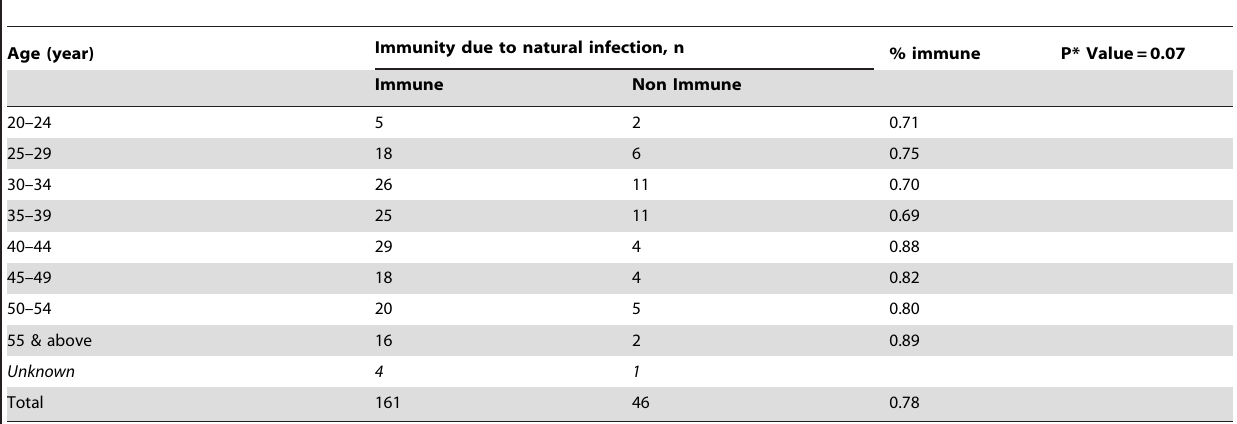
Table 4. Prevalence of immunity due to natural infection (previously infected; Anti-HBc positive and HBsAg negative) by age group in personnel at Niamey’s National Hospital, Niger,